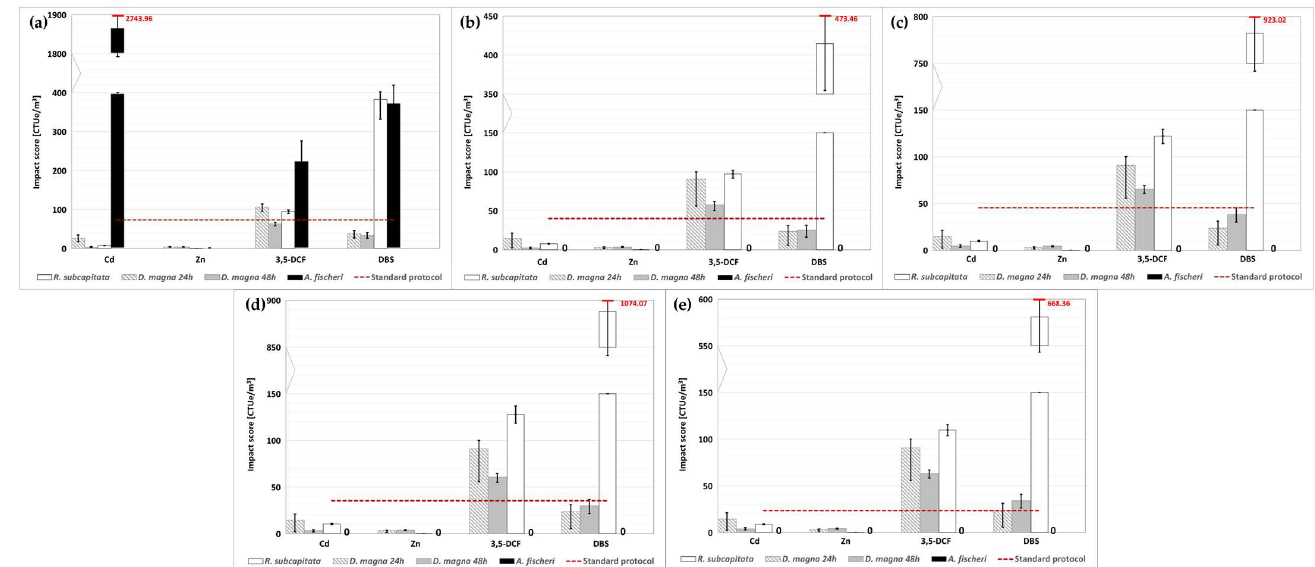
Figure 3. Environmental footprint related to freshwater ecotoxicity calculated with the alternative protocol. ( a ) WWTP A; ( b ) WWTP B, routine time; ( c ) WWTP B, harvest time; ( d ) WWTP C, CAS; ( e ) WWTP C, MBR (the red dotted line represents the conventional impact score calculated without considering the substances detected above the LOQ).